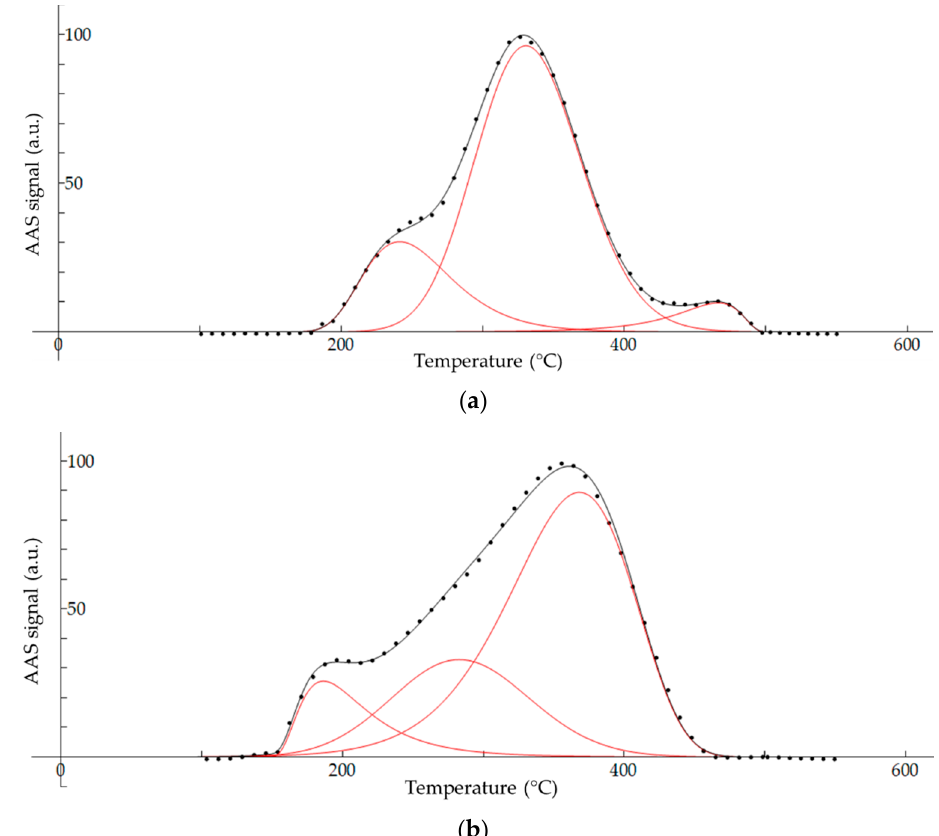
Figure 3. Peak deconvolution of fractionation thermograms for ( a ) AIC-500 and ( b ) in-house prepared iodinated activated carbon (0.01 mol L − 1 NH 4 I) assuming log-normal distribution of constituent peaks. Black dots represent smoothed experimental points (weighted least squares method), red curves deconvoluted peaks and the black curve the summarized model (sum of red curves). Parts of the thermograms below 100 °C and above 550 °C were removed for clarity as the values for AAS signal were about zero. a.u.—arbitrary units.